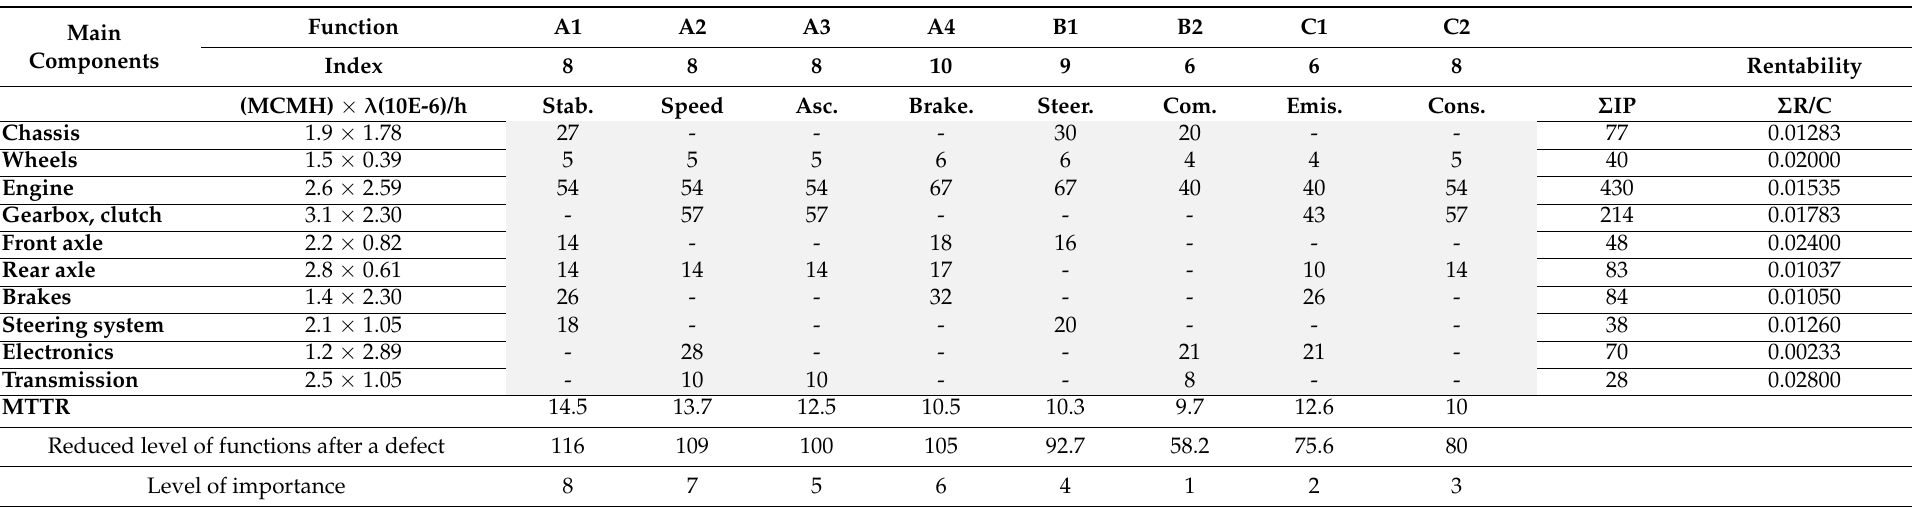
Table 5. MCMH matrix (matrix of mean corrective maintenance